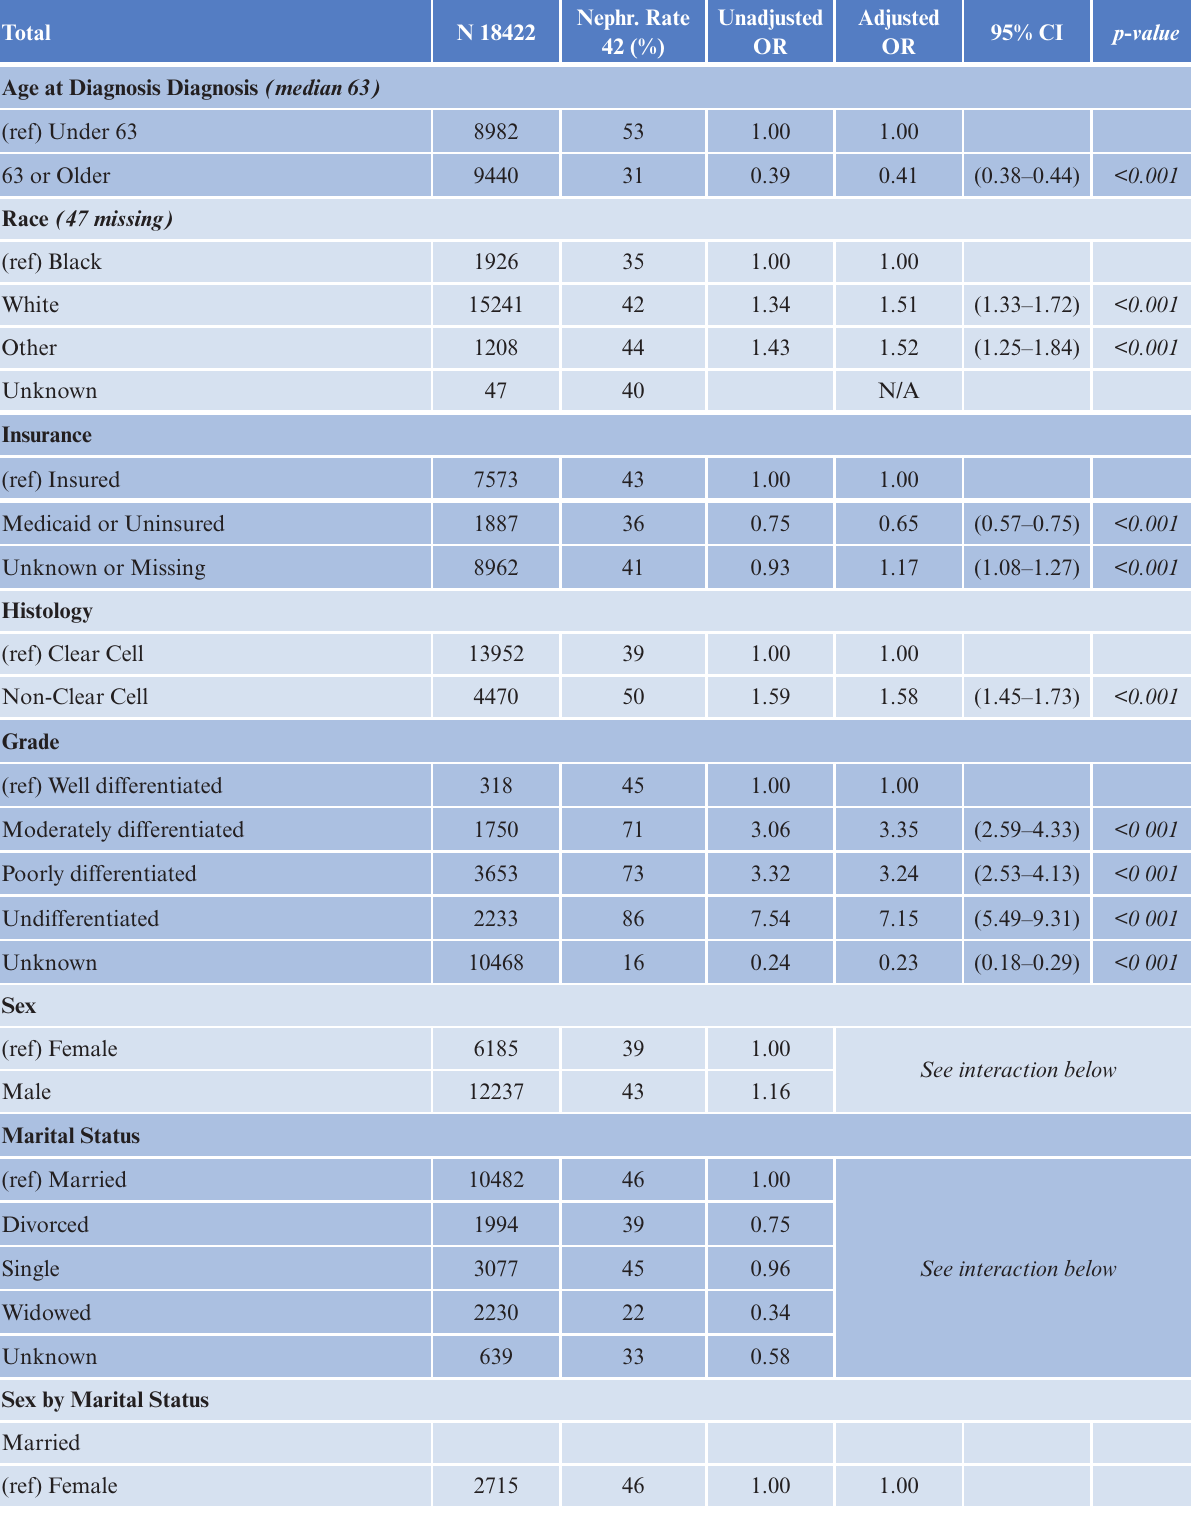
Table 2: All SEER Distant Stage Kidney Cancer: 2000–2013; Odd Ratios for Likelihood of Nephrectomy.